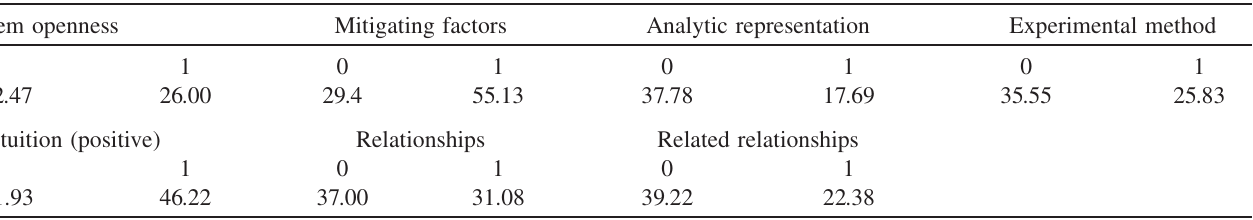
TABLE VII. Percent of correct answers with respect to categories of statistically significant predictors; coding is in line with the item coding instruction (see Table XII).